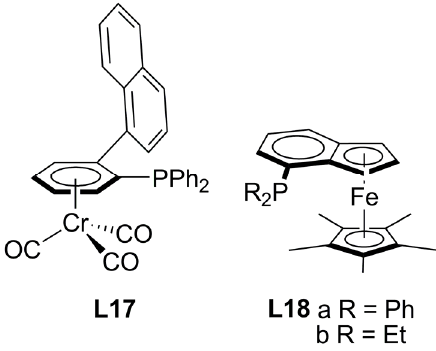
Figure 5. Monophosphine ligands with planar